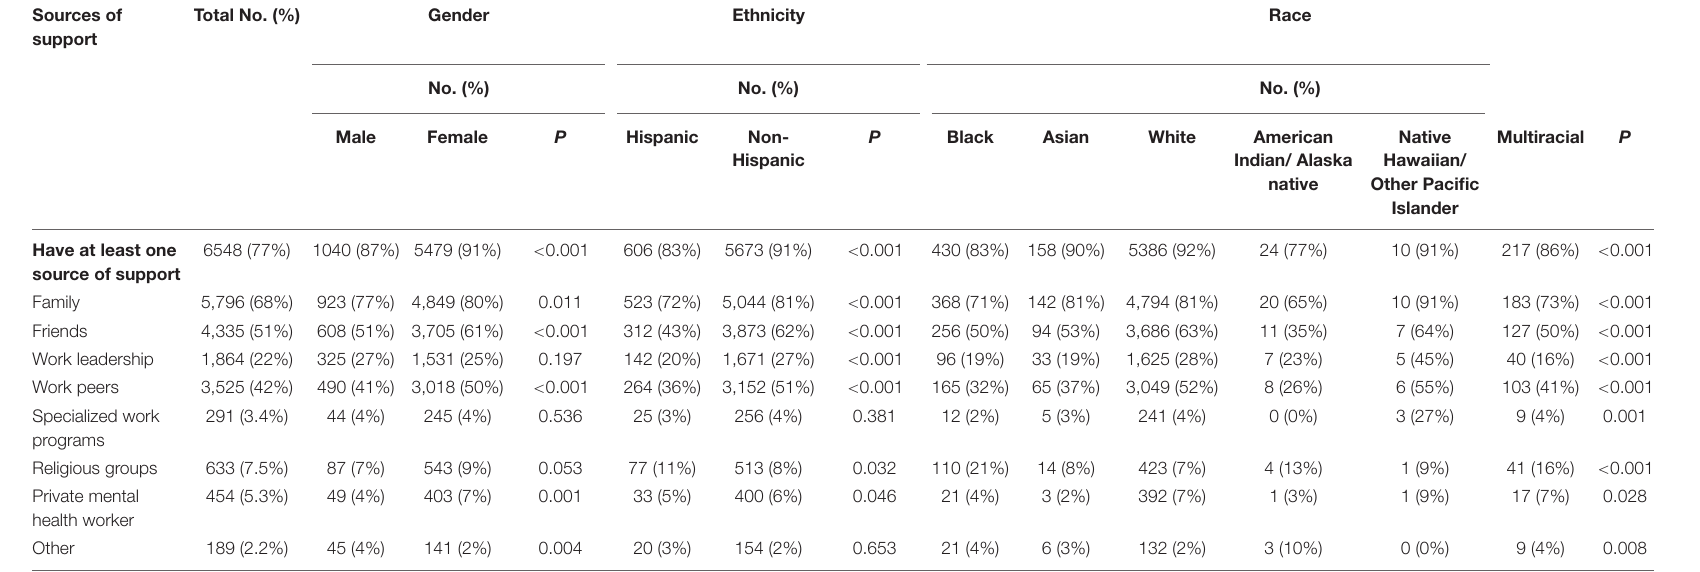
TABLE 5 | Sources of support endorsed by